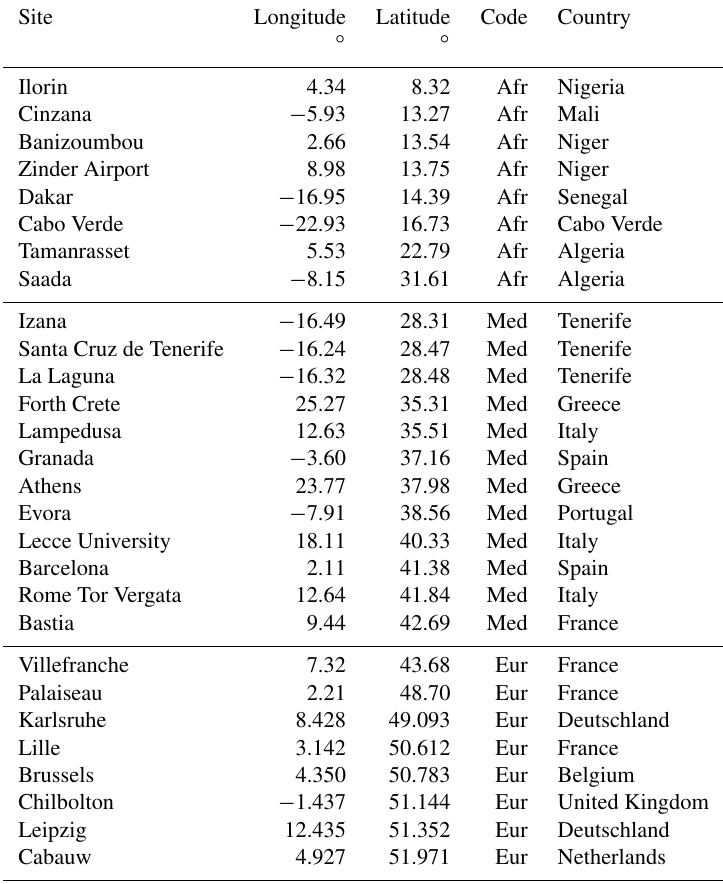
Table 2. Names and locations of the AERONET stations used for model comparisons to AOD and ASD data. The stations are ordered from south to north. The altitude a.s.l. is not presented, the measurements being representative of the vertically integrated atmospheric column above ground level (a.g.l.). The three codes are designed to clusterize the results at the end of this study; the classification mainly depends on the latitude of the station to split the domain into three main parts: Afr (for latitude below ≈ 30 ◦ N), Med (between latitude ≈ 30 and ≈ 45 ◦ N) and Eur (for latitude up to ≈ 45 ◦